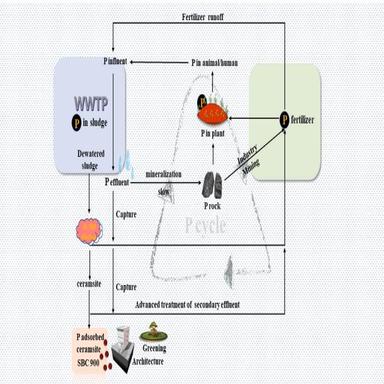
Phosphorus cycle in wastewater plants.